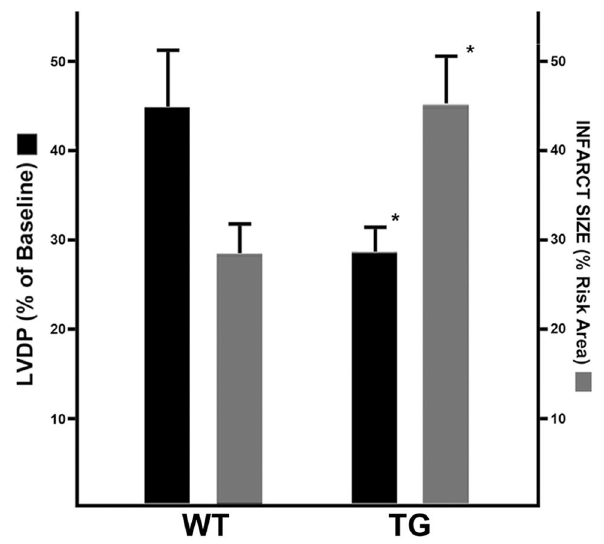
Figure 9. NTT-MMP-2 transgenic hearts exhibit enhanced injury following ex vivo ischemic-reperfusion injury. Isolated hearts were subjected to ex vivo ischemia/ reperfusion injury (30 min/30 min) as detailed in Materials and Methods. Left ventricular developed pressure (LVDP) and infarct size were measured as detailed in Materials and Methds. Recovered LVDP, expressed as the per cent of baseline LVDP, was significantly reduced in the NTT-MMP-2 transgenic hearts. Infarction size was increased by nearly 50% in the transgenic hearts. (n = 5–6 for each study group; *